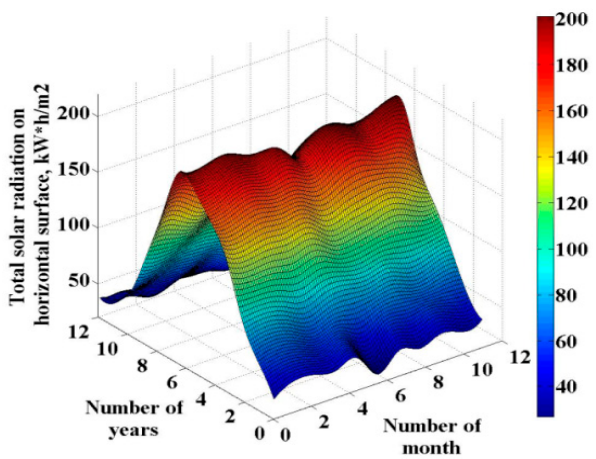
Figure 6. Solar radiation over the past 12 years.